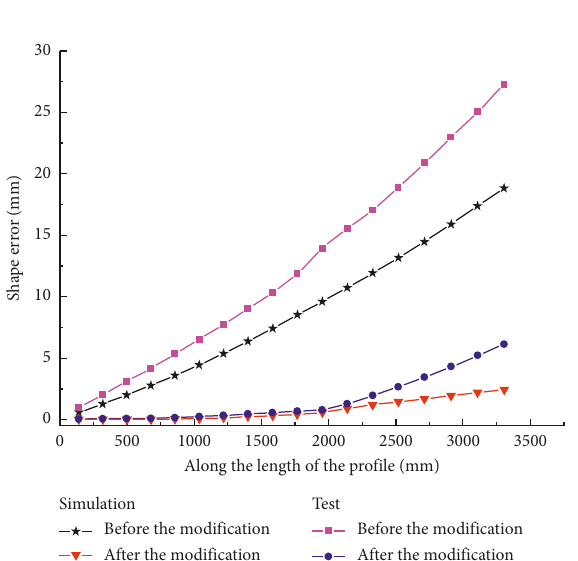
Figure 14: The detection setup and the forming part through the MPSB process.